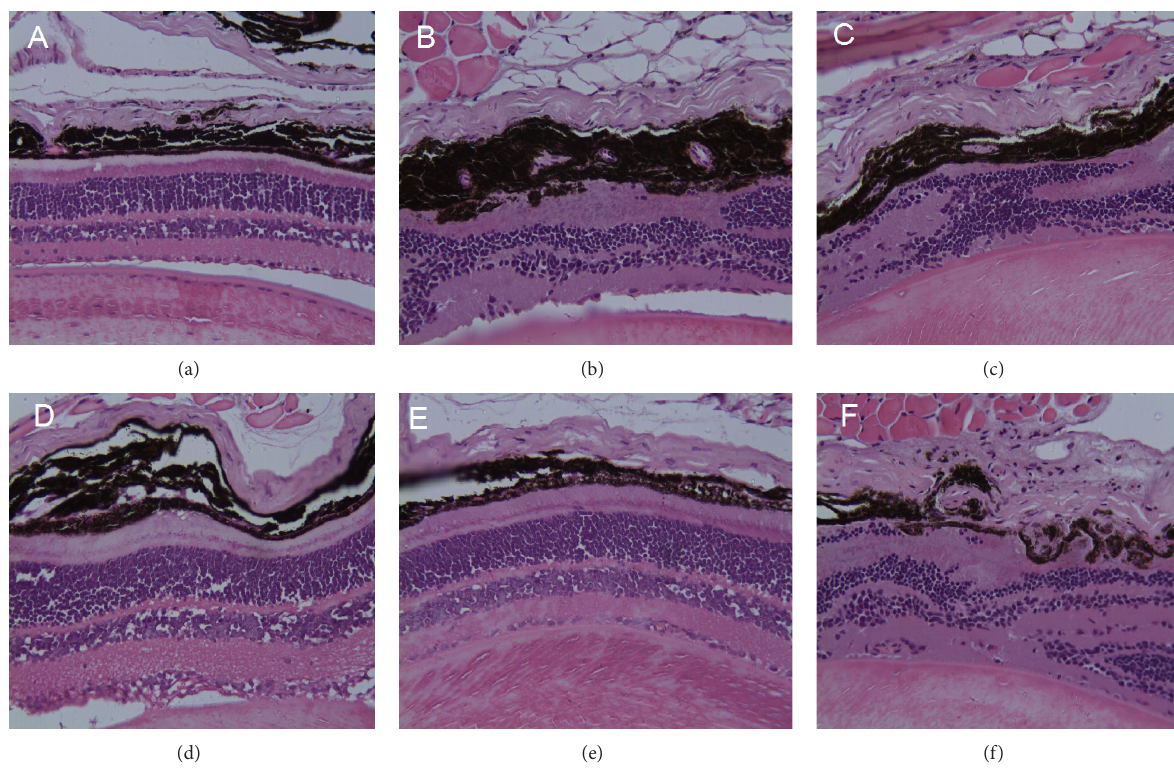
Figure 13: Pathological examination of fundus in db/db mice. (a) Fundus oculi from a normal mouse. (b) Retinopathy from db/db mice, featuring neuron loss and glioses in the ganglion cell layer. (c) Retinal lesions from metformin-treated db/db mouse. (d), (e), and (f) Mildly alleviated retinal lesions in the TNTL-treated db/db mouse at the dose of 3.6 g, 1.8 and 0.9 g/kg b.w.,